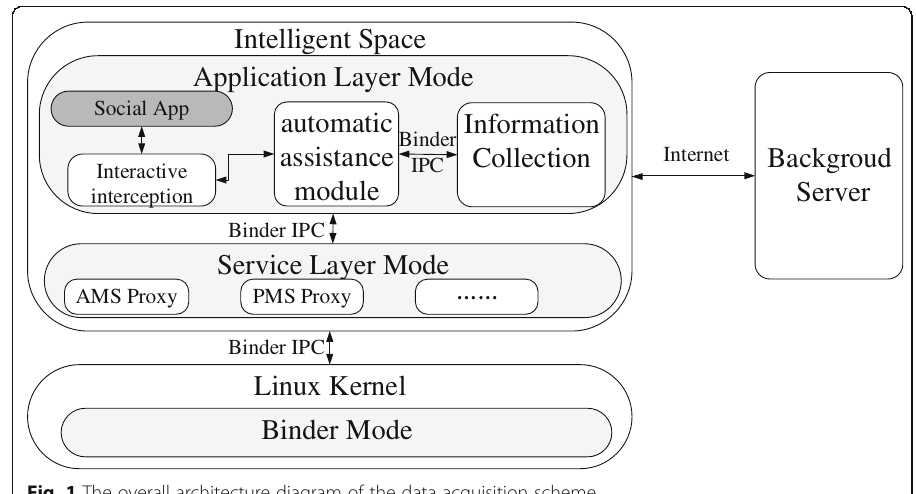
Fig. 1 The overall architecture diagram of the data acquisition